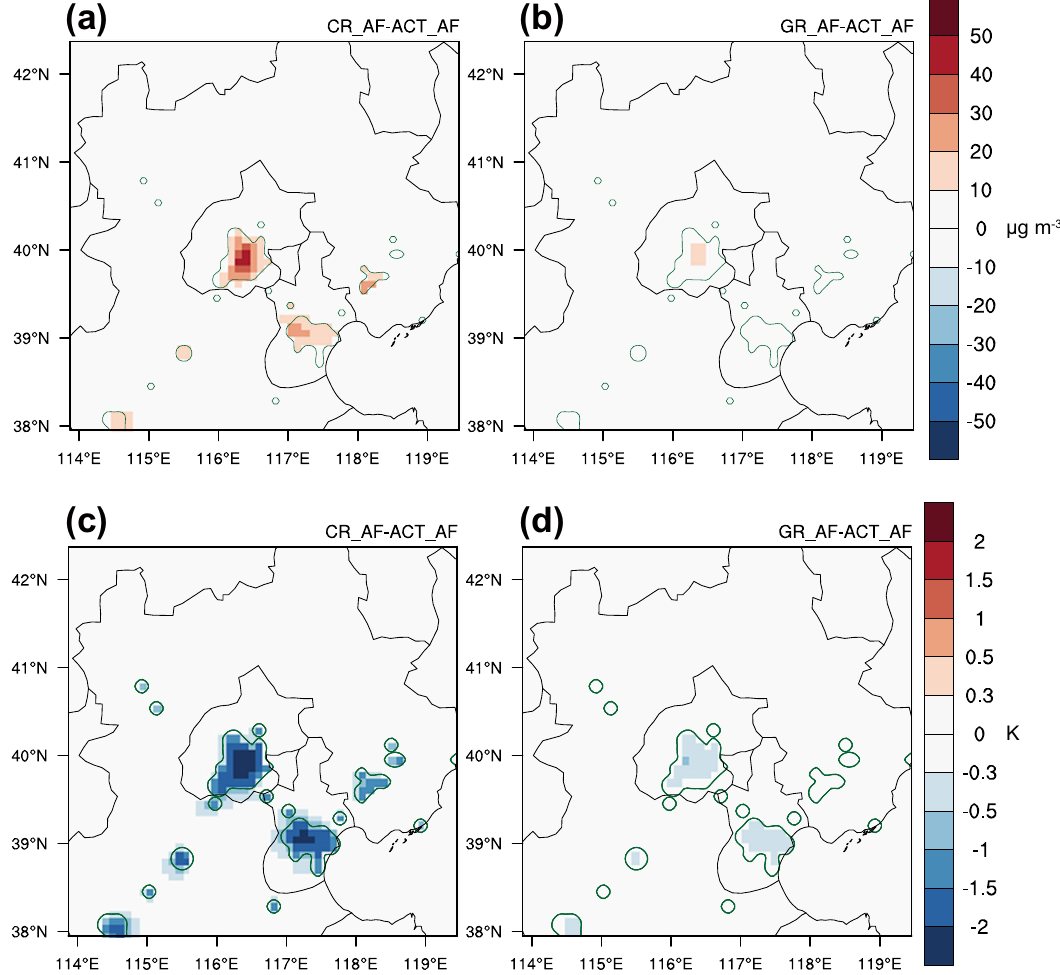
Fig. 1 Spatial features of difference in daytime PM 2.5 concentration and 2 m air temperature. Difference in daytime (9:00 – 17:00 LST) a, b near-ground PM 2.5 concentration and c, d 2 m air temperature from 14 to 20 January 2010. Green circles represent the locations of urban grids. The impacts of cool roofs are indicated by differences between CR_AF and ACT_AF, while the in fl uences of green roofs are denoted with differences between GR_AF and